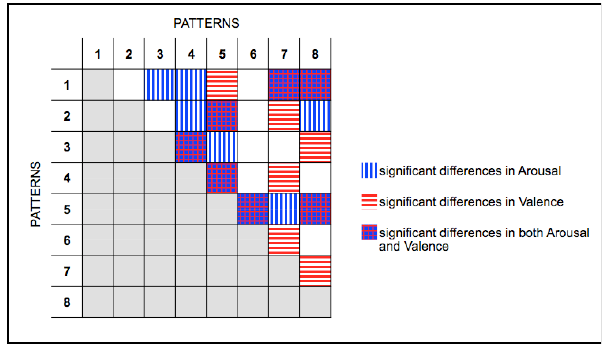
Figure 4. Confusion matrix for the 8 haptic patterns with cell representing pairs of patterns with significant differences in Arousal and